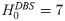
Response of the network model in the case of periodic stimulation patterns.The graphs (A-B) show the β-Power and root mean square value of the activity computed from the cortical LFP signal (Eq 9), when a periodic stimulation pattern configured with an amplitude of H0DBS=7 was applied to the STN nuclei. (A) β-Power as a function of the stimulation frequency fDBS using the pulse width δ as a parameter. The β-Power has been normalized with respect to that obtained for the system in the oscillatory state without stimulation (H0DBS=0). The solid vertical line indicates the stimulation frequency at which the period doubling bifurcation occurs (fd). (B) Effect on the 〈ACrms〉 of increasing the pulse width δ from 0.5 ms to 2 ms. The dashed vertical lines indicate the frequency for activity total suppression fs determined from the 〈ACrms〉 curve. The solid vertical line indicates the frequency for period doubling fd determined from the β-Power curve (graph (A)). The 〈ACrms〉 correspond to the root mean square value of the activity averaged over all the cortical neurons.